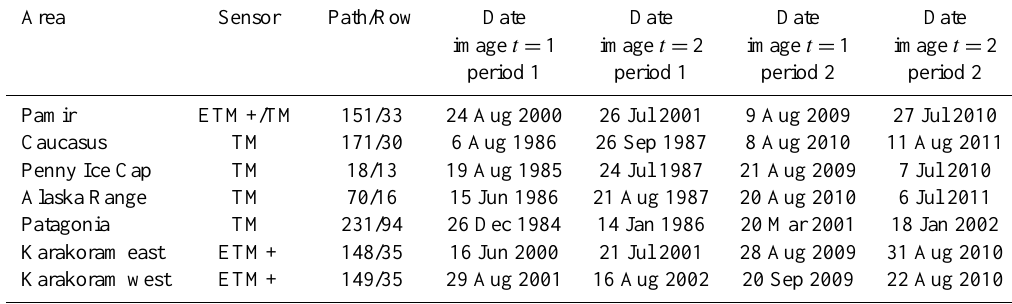
Table 3. Overview of the image pairs used in this study. Path/Row refers to the Landsat satellite orbit coordinate system. Area